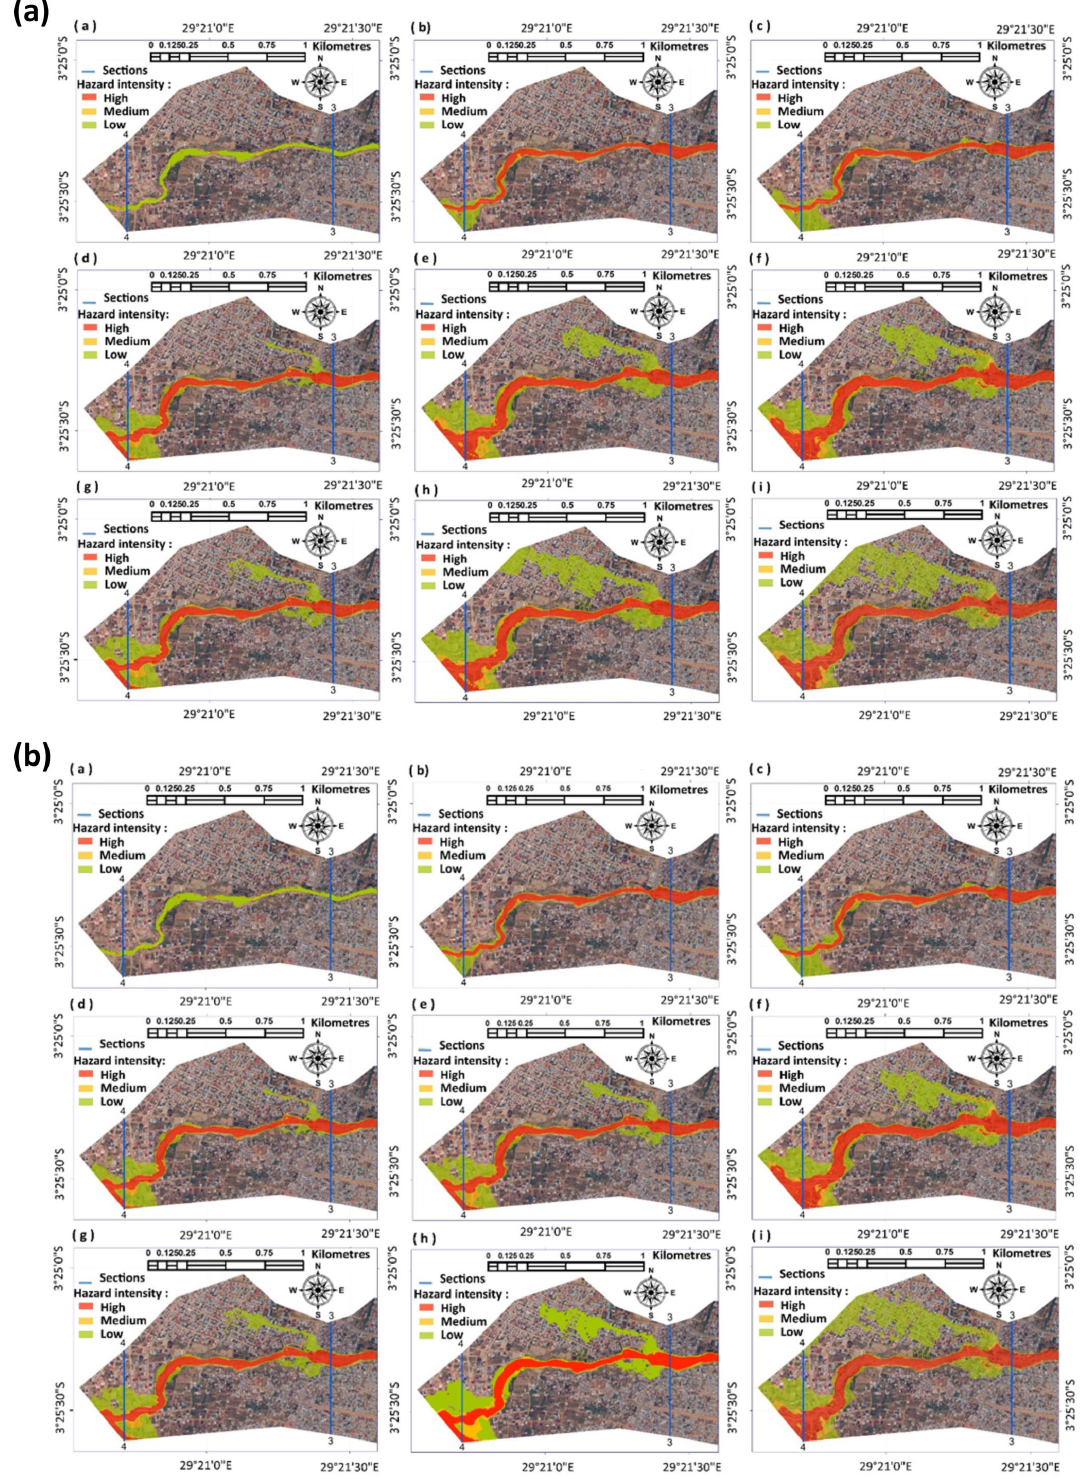
Figure 15. Flood intensity maps for various initial steady discharges and roughness: the first column (subfigures a, d, g) corresponds to the pre-failure scenarios, while the second (subfigures b, e, h) and third (subfigures c, f, i) columns relate to the gradual ( a 10min and b 60min as breaching time) and instantaneous breaching. The first line (subfigures a, b, c) is based on the base flow and a roughness height of 0.1m. The scenarios of the second line (subfigures d, e, f) are simulated using a 50-year flood and a roughness of 0.1m. The third line (subfigures g, h, i) is similar to the second one but considers a roughness height of